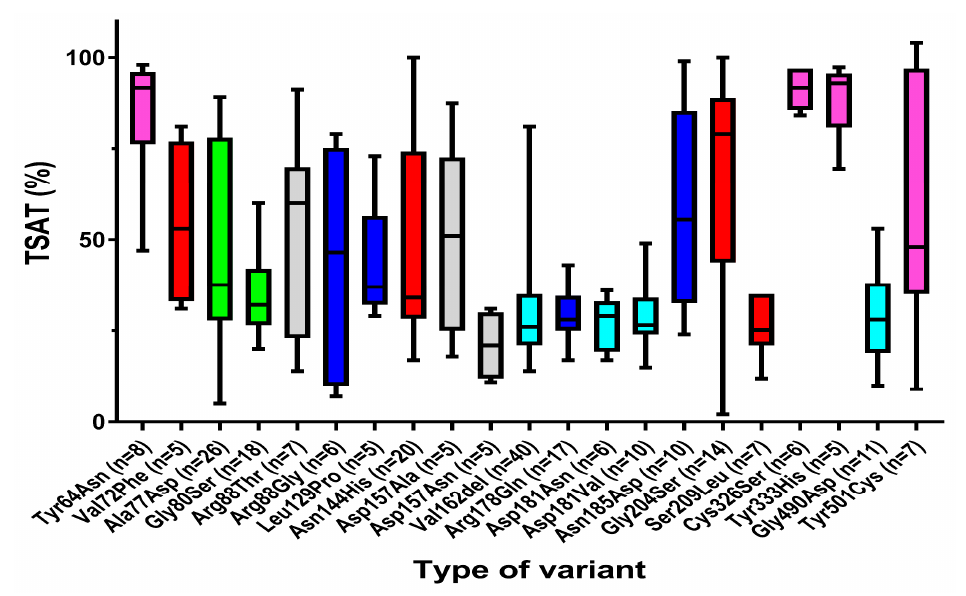
Figure 1 . Box plots (Whiskers: min to max) of transferrin saturation (TSAT) in individuals with ferroportin variants. Only the variants with at least five reported TSAT levels in patients are included. Red: GOF without or conflicting data about hepcidin sensitivity; Pink: GOF hepcidin-resistant variants; Green: LOF without or conflicting data about hepcidin sensitivity; Light blue: LOF hepcidin-resistant variants; Blue: LOF hepcidin-sensitive variants; Gray: No data available.